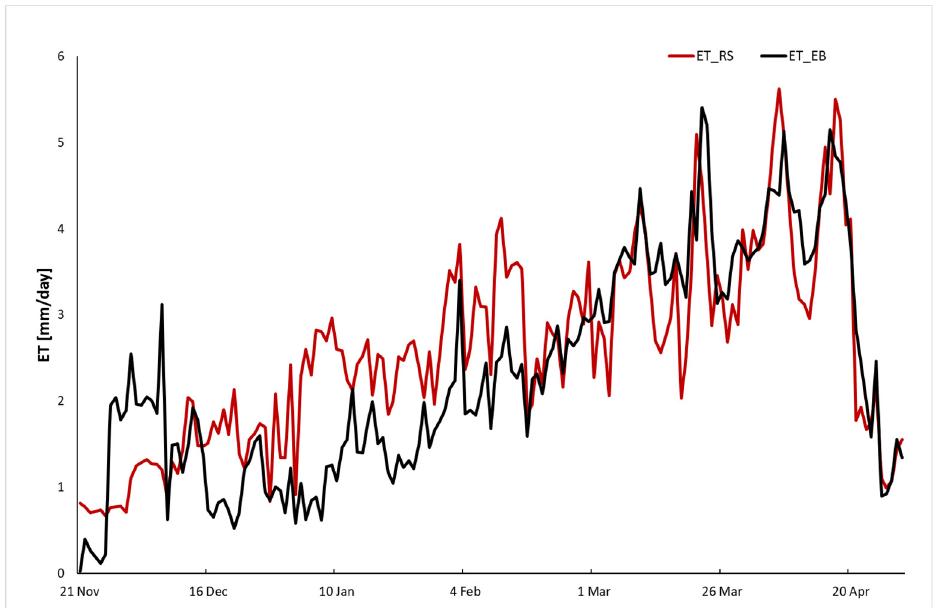
Figure 11. Comparison between daily measured and remote-sensed ET for the period from 21 No-